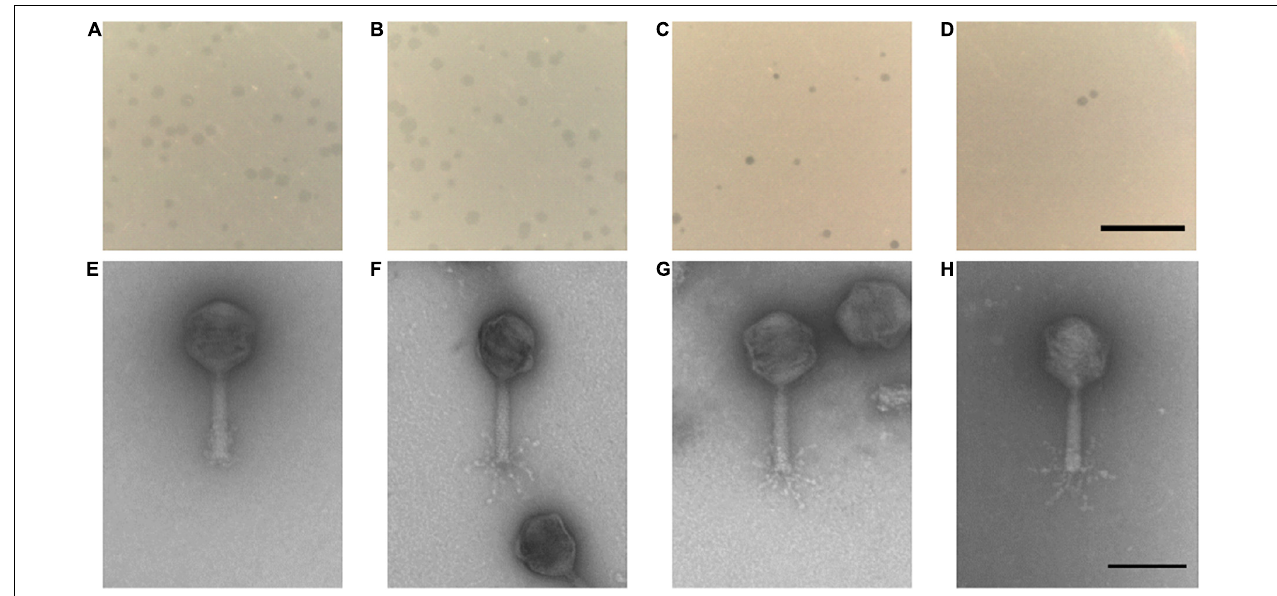
FIGURE 2 | (A–D) Plaque morphology of the four examined myovirus phages (E–H) and micrographs showing the morphology of the virions. All four phages vB_CjM-LmqsCP132-3c (A,E) , vB_CjM-LmqsCP1-5 (B,F) , vB_CjM-LmqsCP74-2c1 (C,G) , vB_CjM-LmqsCP1-4 (D,H) formed clear plaques on C. jejuni strain NCTC 12662; scale bar represents 2 mm. The virions consisted of an icosahedral head and a contractile tail structure with tail fibers; negatively stained phage particles with 2% uranylacetate, scale bar represents 100